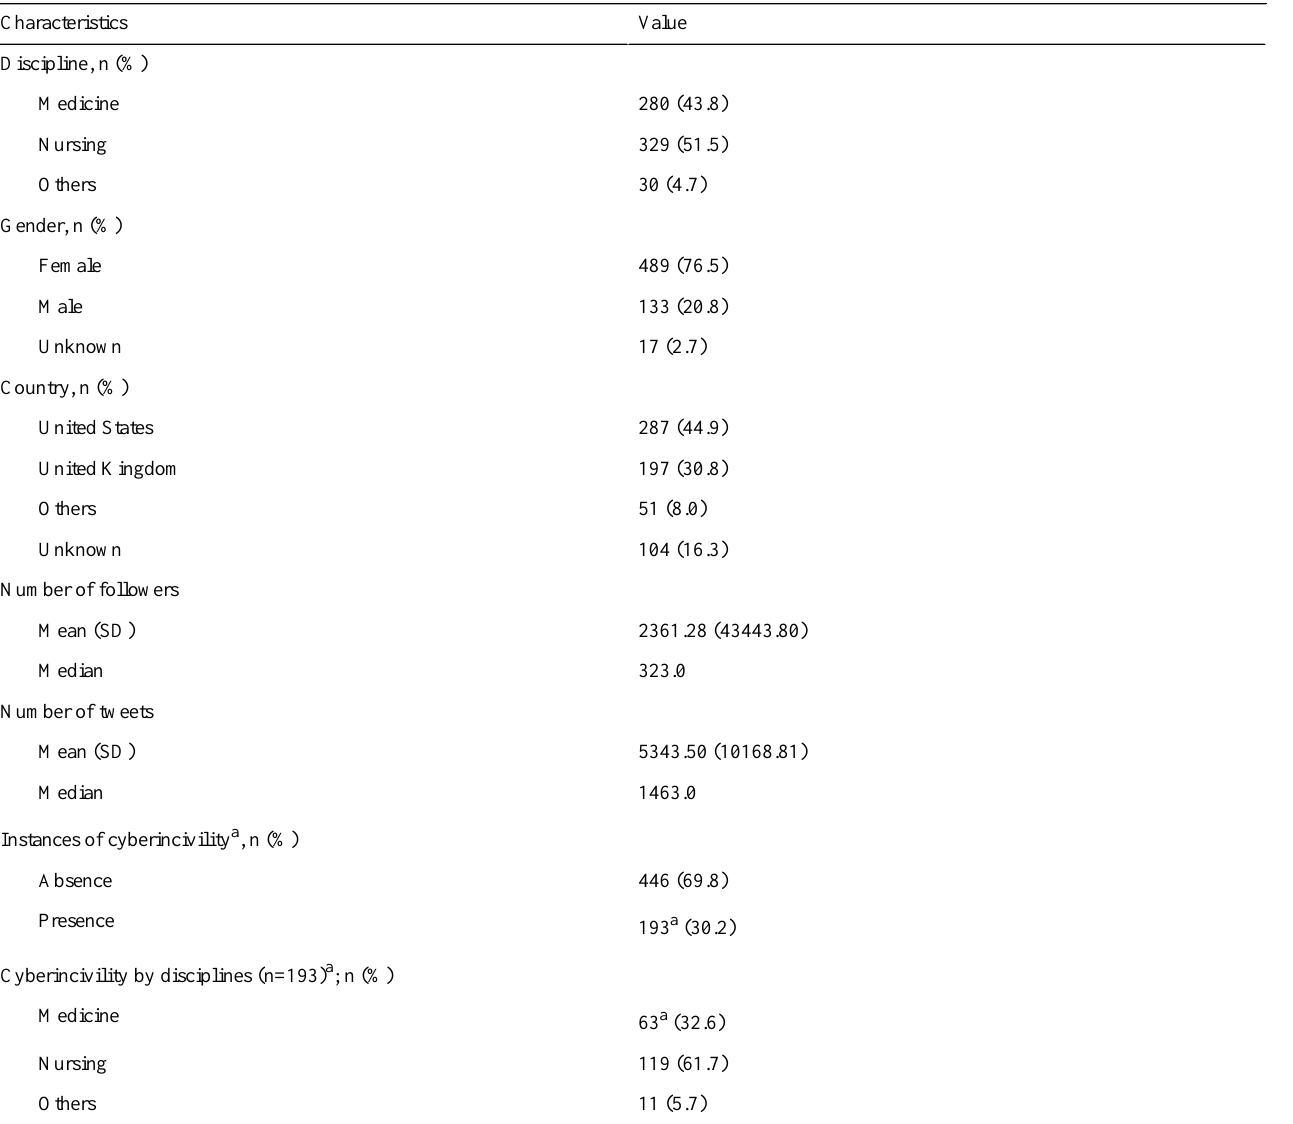
Table 2. Sample characteristics of users